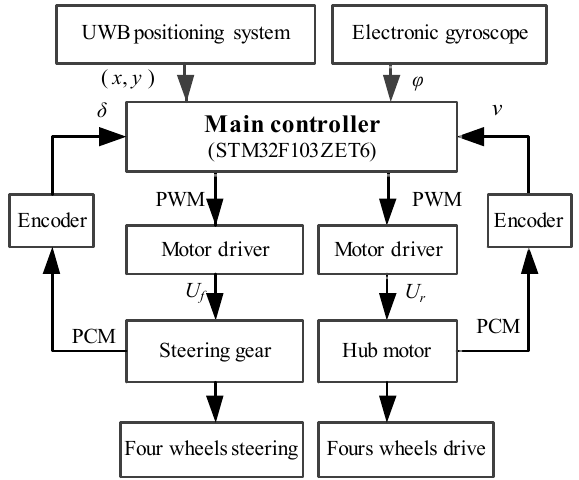
Figure 2. System control process.